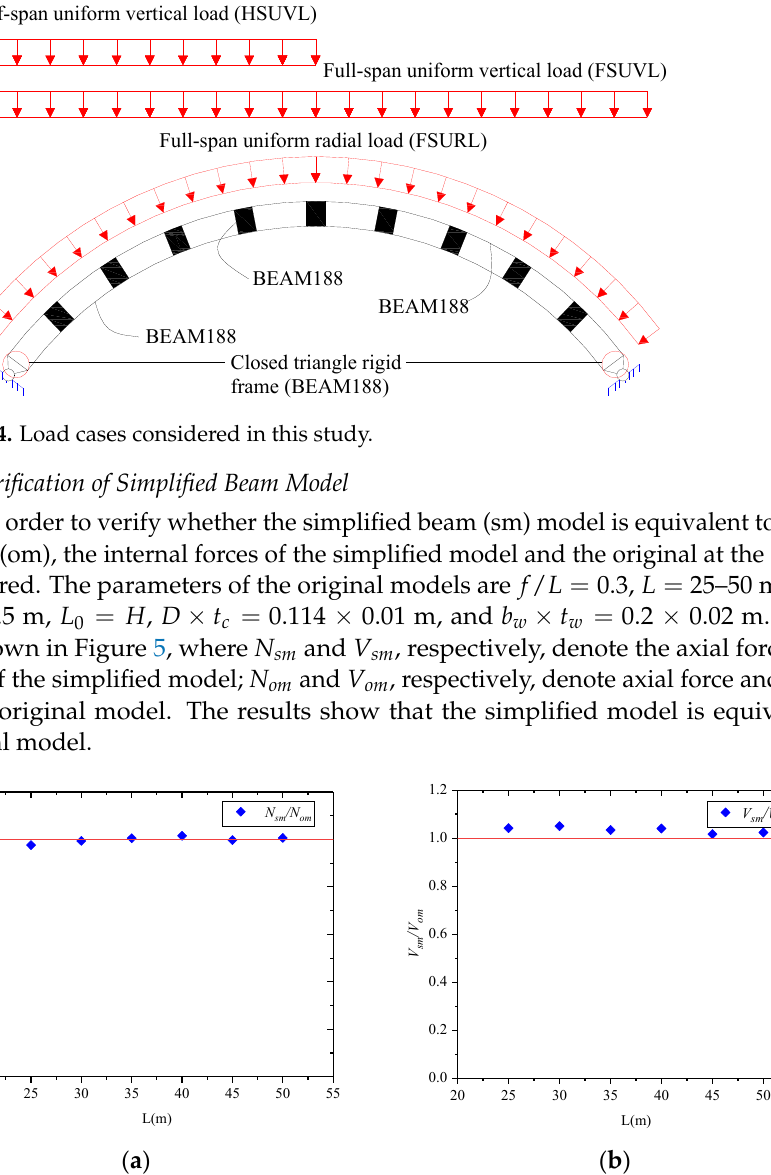
Figure 5. Comparison of internal force at arch foot: ( a ) comparison of axial force; ( b ) comparison of shear force.